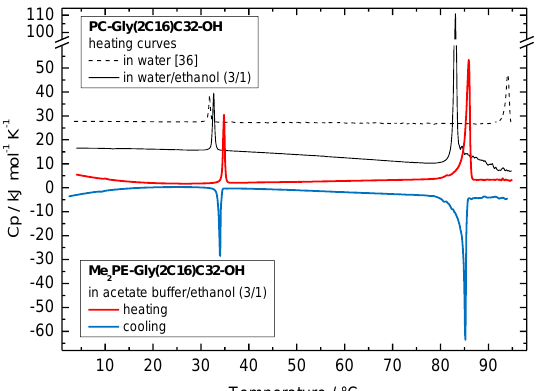
Figure 3. Differential scanning calorimetry (DSC) heating (red solid line) and cooling (blue solid line) curve of a Me 2 PE-Gly(2C16)C32-OH suspension ( c = 1 mg mL −1 ) in a mixture of acetate buffer (pH = 5.0, 10 mM) and ethanol (3/1, v / v ). The DSC heating curves of PC-Gly(2C16)C32-OH either in water/ethanol (3/1, v / v ; black solid line) or in water (black dashed line) are shown for comparison. The heating rate was 60 K h −1 . The curves are shifted vertically for clarity.